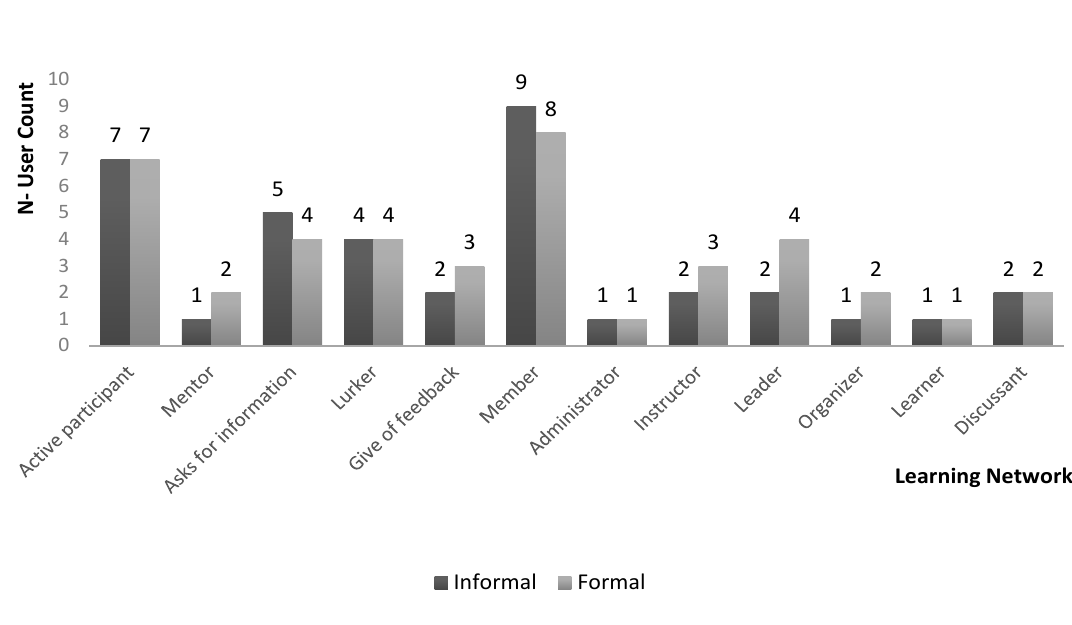
Figure 3 . Students’ roles in informal and formal learning networks.